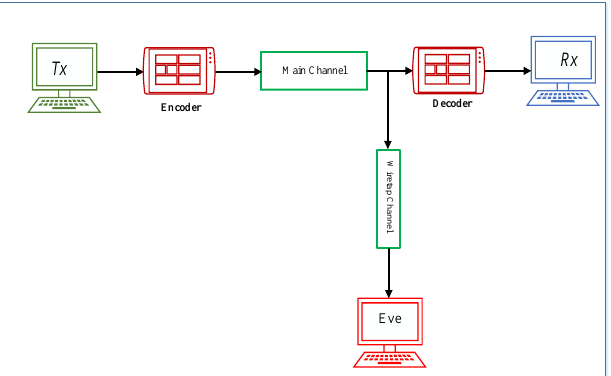
Figure 1. A Wiretap Channel for Privacy Capacity